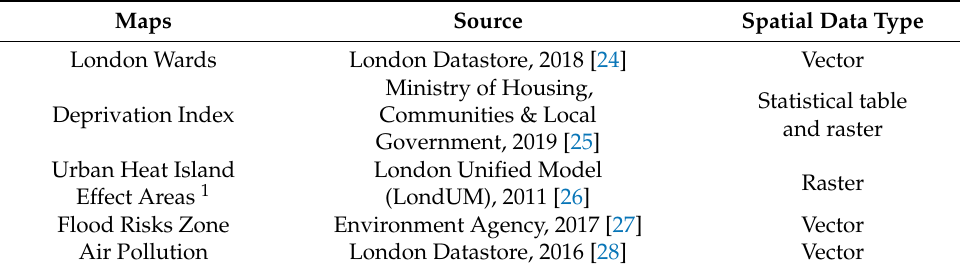
Table 1. London case study.